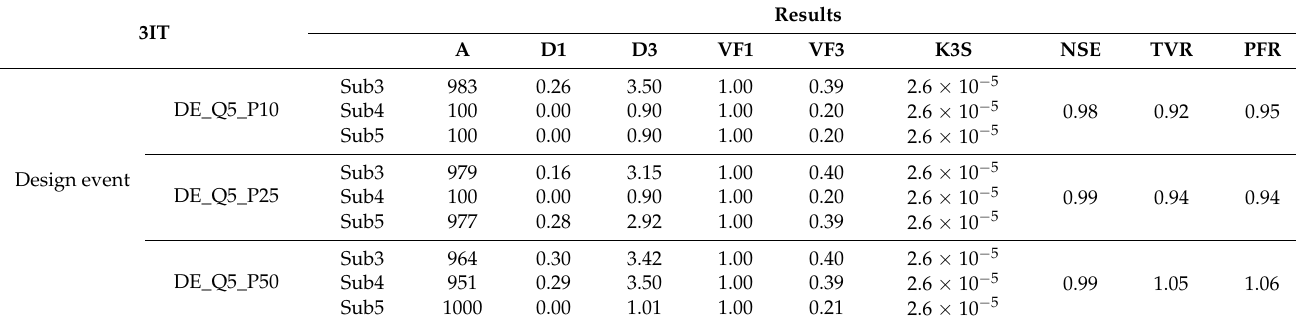
Table A4. The results of the 3IT scenario, which includes three types of an infiltration